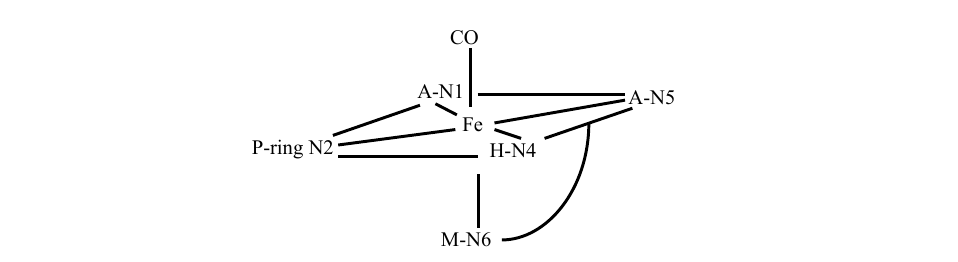
Figure 11. Arreangement of BLM lingndas in CO-Fe(II)BLM proposed by Oppenheimer et al.